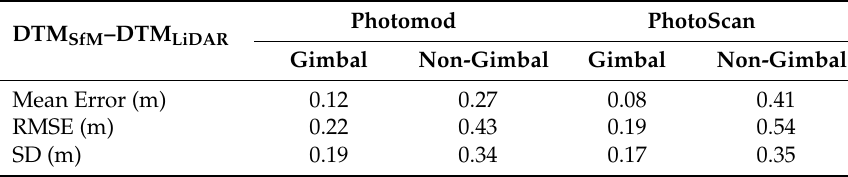
Table 2. The results of the comparison of the structure from motion (SfM)-based raster digital terrain models (DTM SfM ) and LiDAR (DTM LiDAR ), based on corresponding ground elevation cell difference statistics: mean error, root mean square error (RMSE) and standard deviation (SD). DTM SfM –DTM LiDAR